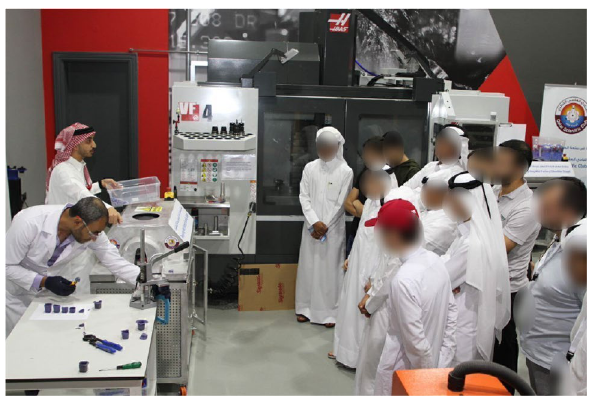
Fig. 25 Teaching students about recycling plastic and operating the recycling